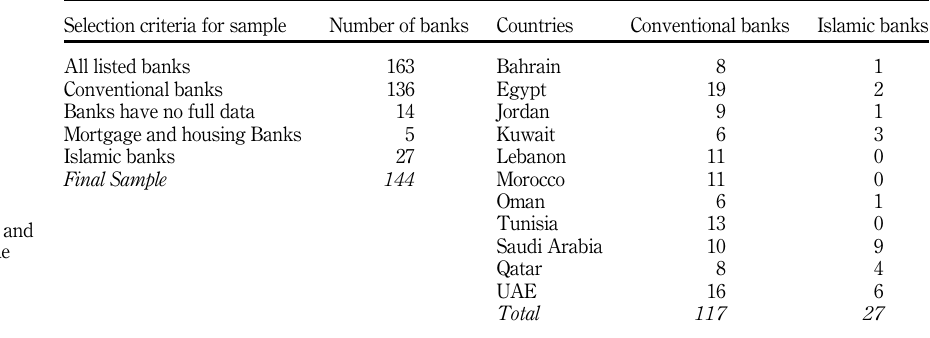
Table 1. Selection criteria and distribution of the sample